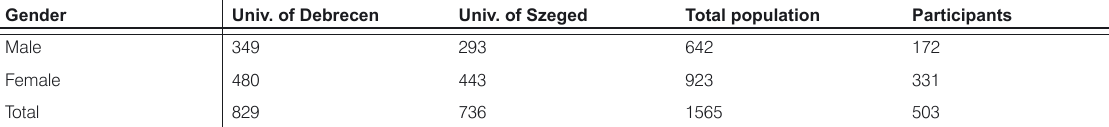
Table 1. Medical students by gender.